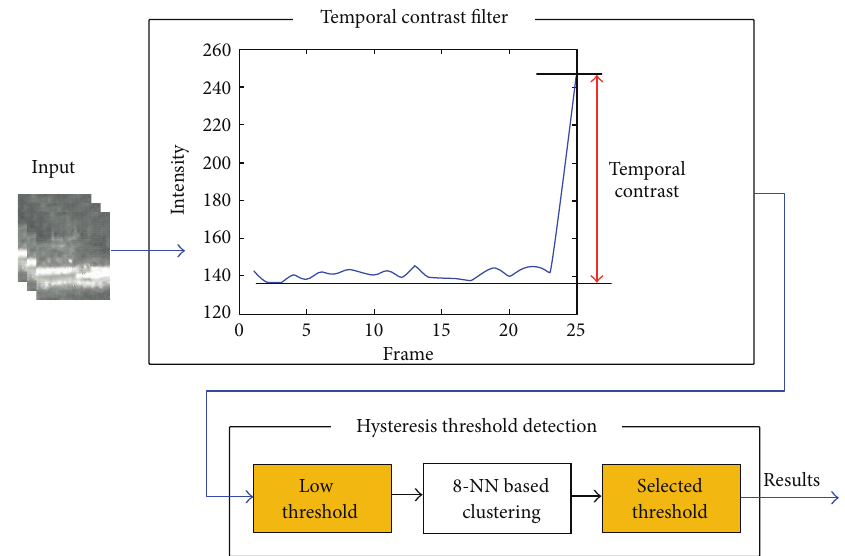
Figure 16: Proposed supersonic target detection system.